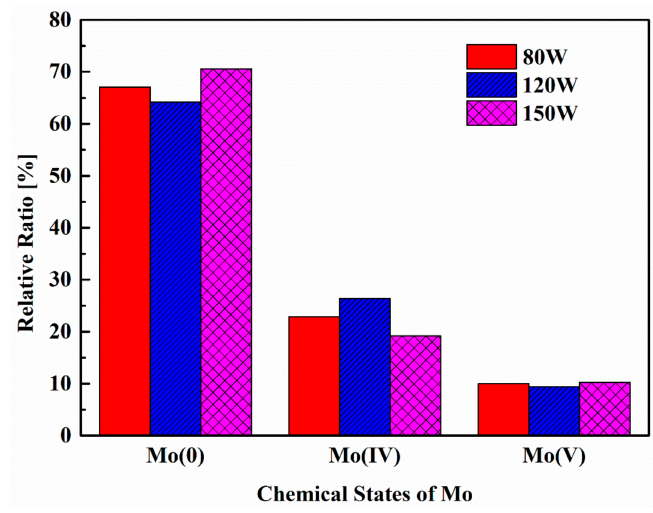
Figure 7. Relative ratio of Mo species with various chemical states at different RF